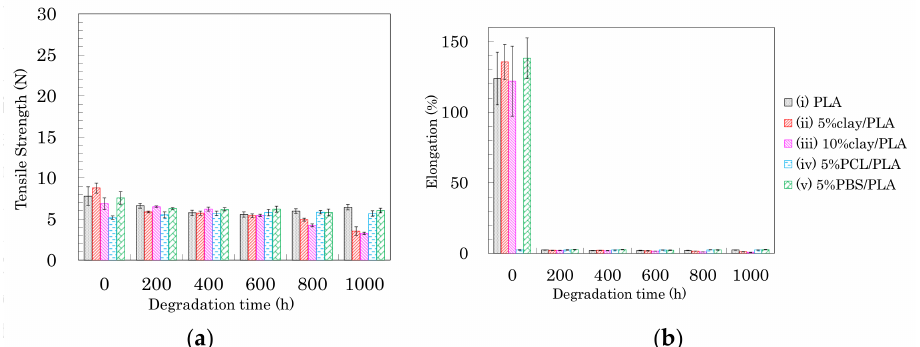
Figure 12. Tensile strength ( a ) and elongation ( b ) of 3 DR PLA fibers plotted versus degradation